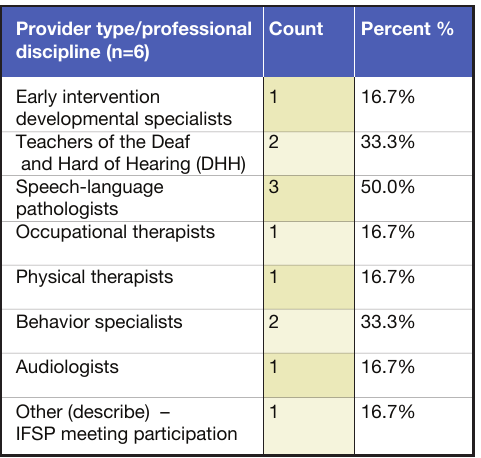
Reimbursement for Telehealth